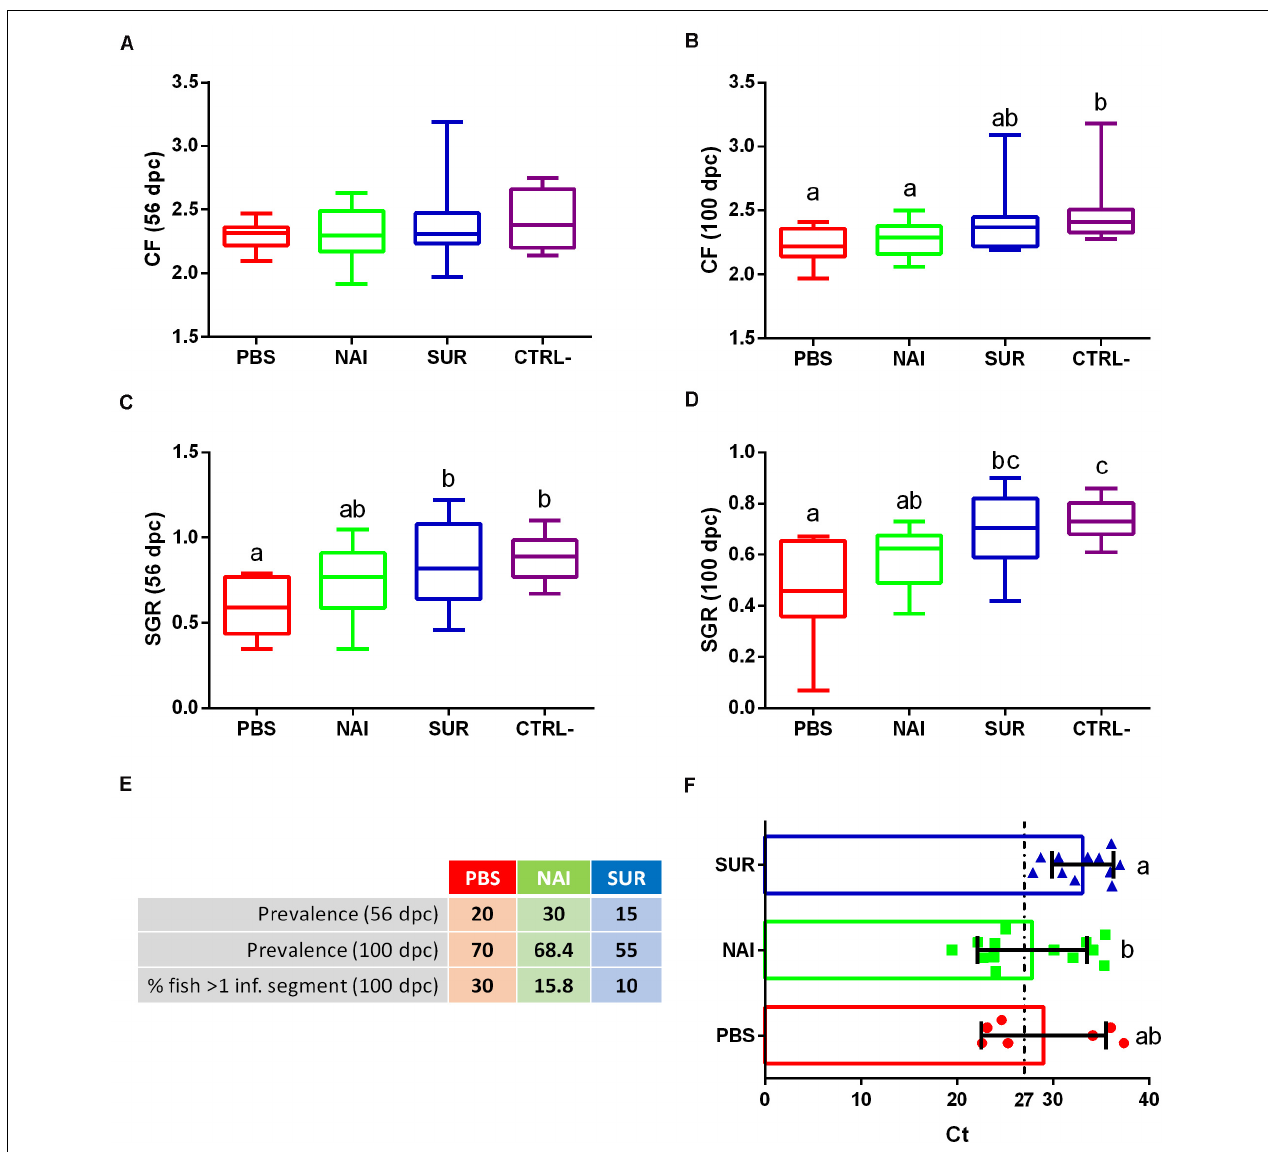
FIGURE 2 | Disease signs and parasite diagnosis. Condition factor (CF), (A,B) and specific growth rate (SGR), (C,D) were calculated for the intermediate (A,C) and final samplings (B,D) . Prevalence of infection is represented as the percentage of infected fish at the intermediate and final samplings (56 and 100 days post-challenge, dpc). The percentage of fish with more than one intestinal segment parasitized (% fish > 1 inf. segment) was calculated at the final sampling (E) . Intensity of infection is shown as Ct values (mean ± SD) obtained from a parasite specific qPCR of the intestine at 100 dpc (F) . Low Ct values indicate high infection intensity. PBS is the group injected with PBS, whereas NAI represent the fish injected with serum without specific antibodies and SUR the fish injected with parasite-specific antibodies. The negative control (CTRL-) was the group not challenged with the parasite. Different letters indicate significant differences among groups ( P <